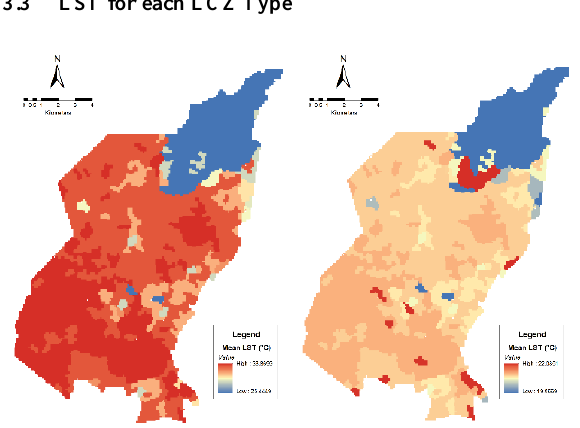
Figure 9. Images of each identified LCZ in Quezon City from ESRI World Imagery Map 3.3